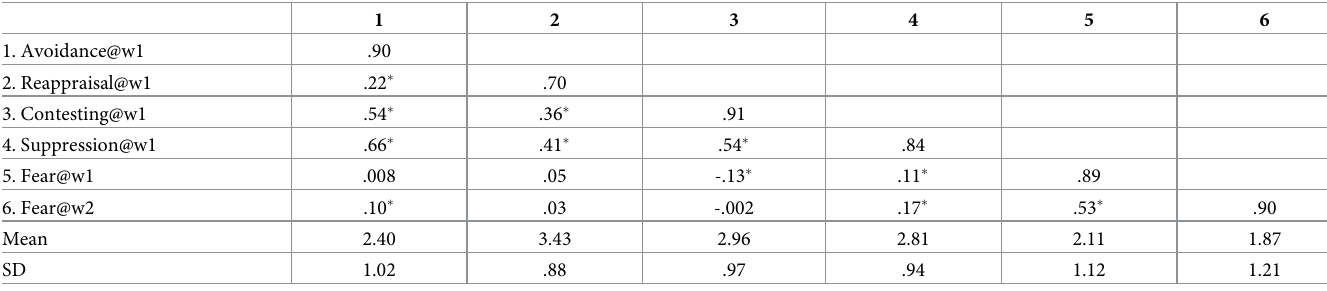
Table 1. Bivariate correlations and descriptive statistics for manifest variables in (mostly) wave